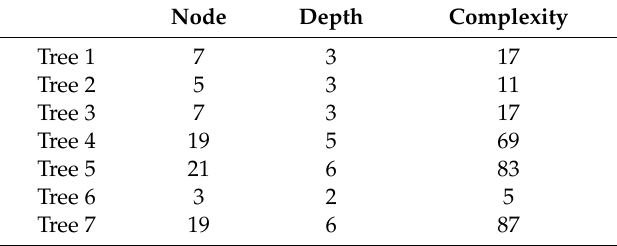
Table 4. Information about Subtrees of Best Model of ABCP-Descriptor for